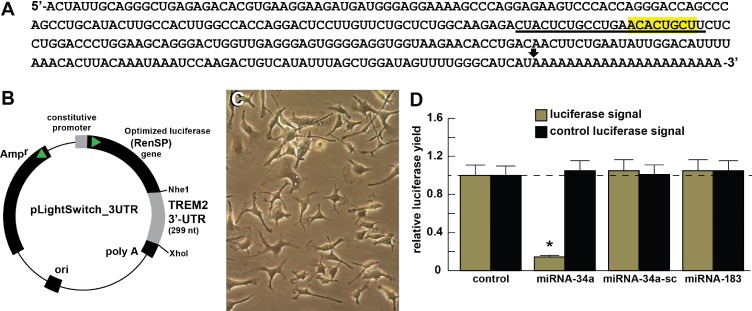
Functional validation of a miRNA-34a-TREM2–3’UTR interaction.(A) ribonucleotide sequence of the 299 nt TREM2-mRNA-3’-UTR is shown in the 5’-3’ direction; the 22 nt miRNA-34a-TREM2 3’UTR complementarity-interaction region is indicated by a black underline and the 8 nt TREM2-mRNA-3’-UTR seed sequence 5’-ACACUGCU-3’ is overlaid in yellow; a single arrowhead indicates the 5’ end of a poly A+ tail in the TREM2 mRNA (22 ‘A’ nt shown; the length of this poly A+ tail is variable); TREM2 mRNA sequence derived from NM_018965; TREM2 transcript is the major X1 variant (see also http://switchdb.switchgeargenomics.com/productinfo/id_801321/) (Fig 3); (B) TREM2-mRNA-3’UTR expression vector luciferase reporter assay (pLightSwitch-3’UTR; Cat#S801178; Switchgear Genomics, Palo Alto CA); in this vector, the entire 299 nucleotide TREM2 3’UTR was ligated into the unique Nhe1-Xho1 site; (C) control C8B4 murine microglial cells, 1 week in culture; phase contrast bright field microscopy 20x; C8B4 cells transfected with the TREM2-mRNA-3’UTR expression vector luciferase reporter were treated exogenously with miRNA-34a, a scrambled control miRNA-34a (miRNA-sc) or control miRNA-183; see references and text for further details [18,19]; (D) compared to control, C8B4 cells transfected with a scrambled (sc) control pLightSwitch-3’UTR vector, the TREM2-mRNA-3‘UTR vector exhibited decreased luciferase signal to a mean of 0.16-fold of controls in the presence of miRNA-34a; this same vector exhibited no change in the presence of the control miRNA-34a-sc or miRNA-183; for each experiment (using different batches of MG cells) a control luciferase signal was generated and included separate appropriate controls with each analysis; in addition a control vector β-actin-3’UTR showed no significant effects on the relative luciferase signal yield after treatment with either miRNA-183 or miRNA-34a (data not shown); dashed horizontal line set to 1.0 for ease of comparison; N = 5; *p<0.001 (ANOVA). The results suggest a physiologically relevant miRNA-34a- TREM2-mRNA-3‘UTR interaction and a miRNA-34a-mediated down-regulation of TREM2 expression in stressed MG cells. This pathogenic ineraction may be related to the down-regulation of other immune system genes by up-regulated pro-inflammatory miRNAs in the CNS [12,19,22] and/or an impairment in cellular phagocytosis or related phagocytic signaling [5–7,20,21].